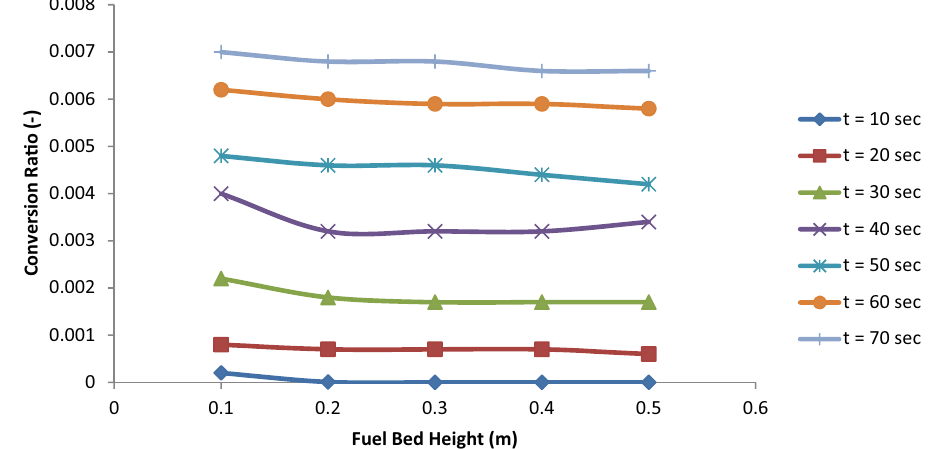
Fig. 5 The CuO conversion as a function of time at different